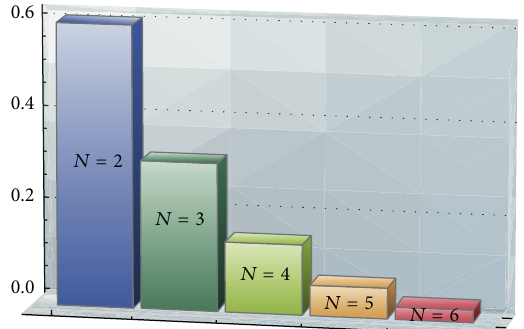
Figure 8: Fraction of search space visited by branch and bound for 𝑁 = 2, 3, 4, 5, 6 .